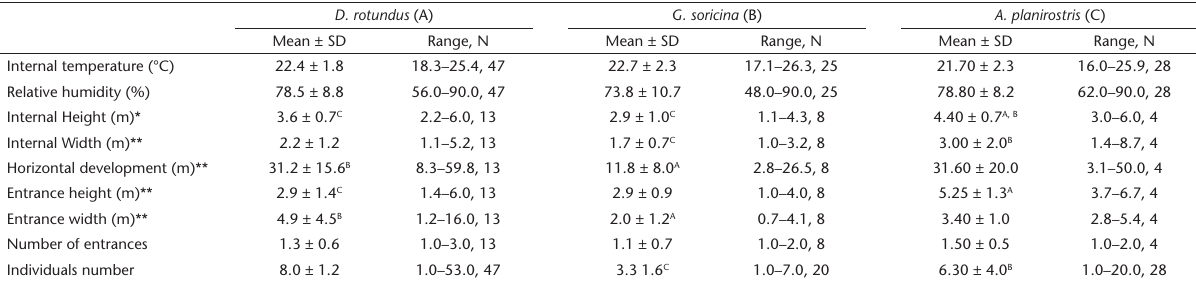
Table 1. Descriptive statistics and comparisons of means of structural and microclimatic characteristics among caves occupied by Desmodus rotundus (n = 13), Glossophaga soricina (n = 8), and Artibeus planirostris (n = 4) at the APA Karst area of Lagoa Santa, Minas Gerais, Brazil. The mean number of individuals found in caves for all inspections is